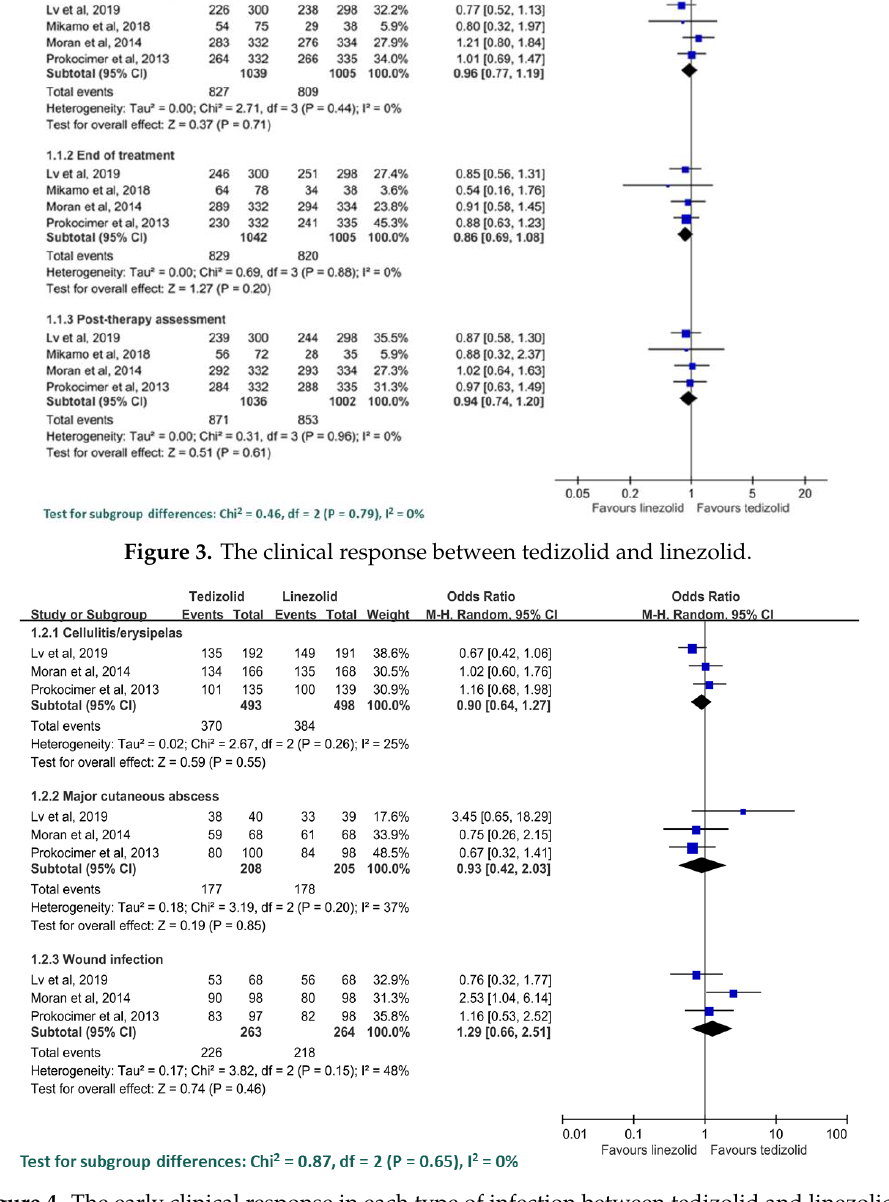
Figure 4. The early clinical response in each type of infection between tedizolid and linezolid.